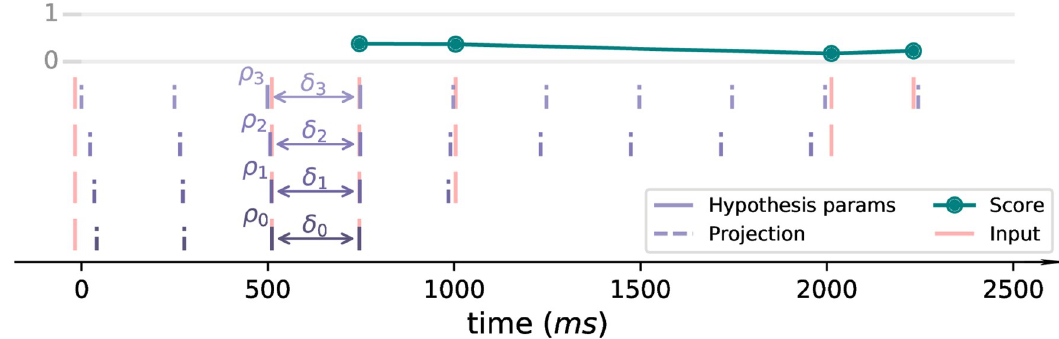
Fig 3. Depiction of a hypothesis tracker and its evolution. First four rows (bottom to top) present the history of the hypothesis tracker parameters ( ρ 1..4 and δ 1..4 ) after processing four new onsets. Top row presents the hypothesis congruency score values after each new onset is